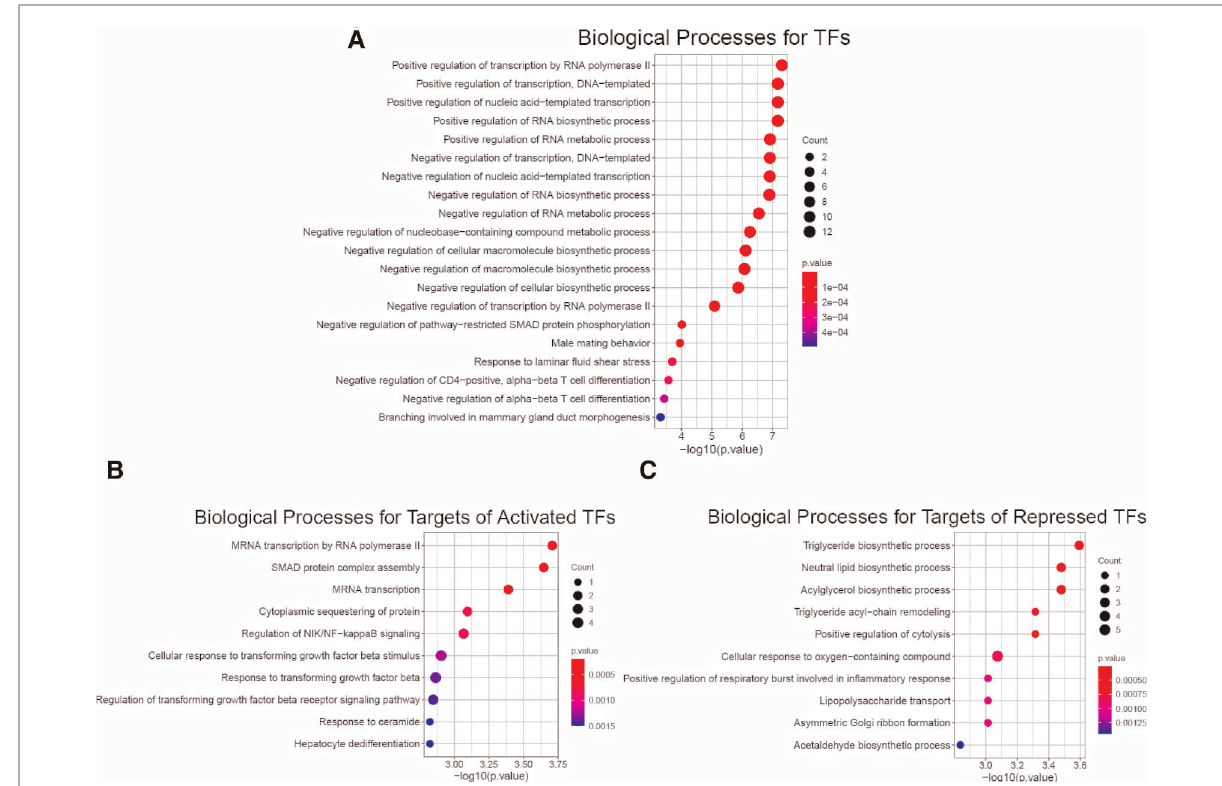
FIGURE 3 Enrichment analysis for 22 common TFs and their targets. ( A ) Biological Process Pathways for 22 common TFs. Pathway terms were ranked according to their − log10 ( p value) values. The dot sizes were proportional to number of genes. ( B ) Top 10 Biological Process Pathways for targets of 14 activated TFs (dataset I, dataset II, dataset III). All the targets and pathways were common in three datasets. Pathway terms were ranked according to their − log10 ( p value) values. The dot sizes were proportional to number of genes. ( C ) Top 10 Biological Process Pathways for targets of 8 repressed TFs (dataset I, dataset II, dataset III). All the targets and pathways were common in three datasets. Pathway terms were ranked according to their − log10 ( p value) values. The dot sizes were proportional to number of